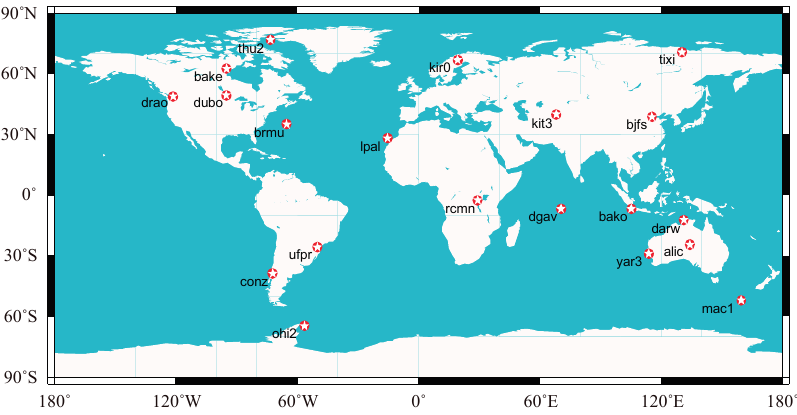
Figure 2. Geographical distribution of 20 IGS (International GNSS Service)